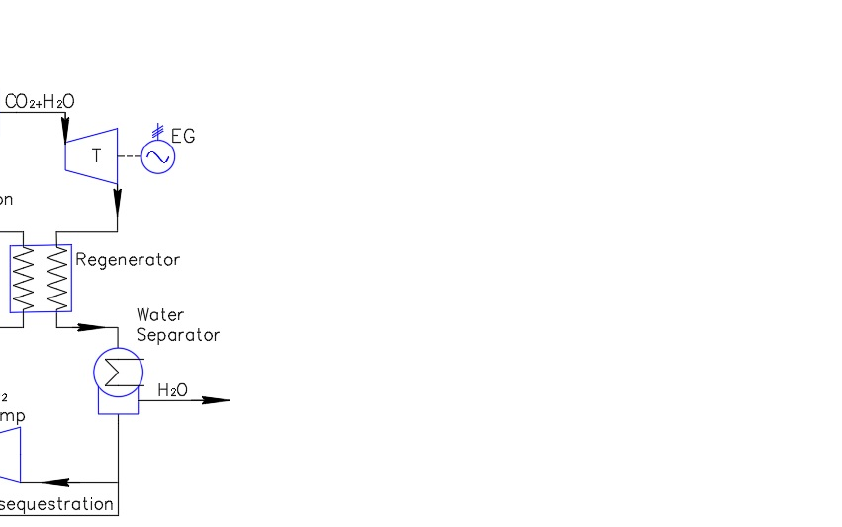
Figure 1. Heat flow chart of a semi-closed cycle with oxy-fuel combustion.